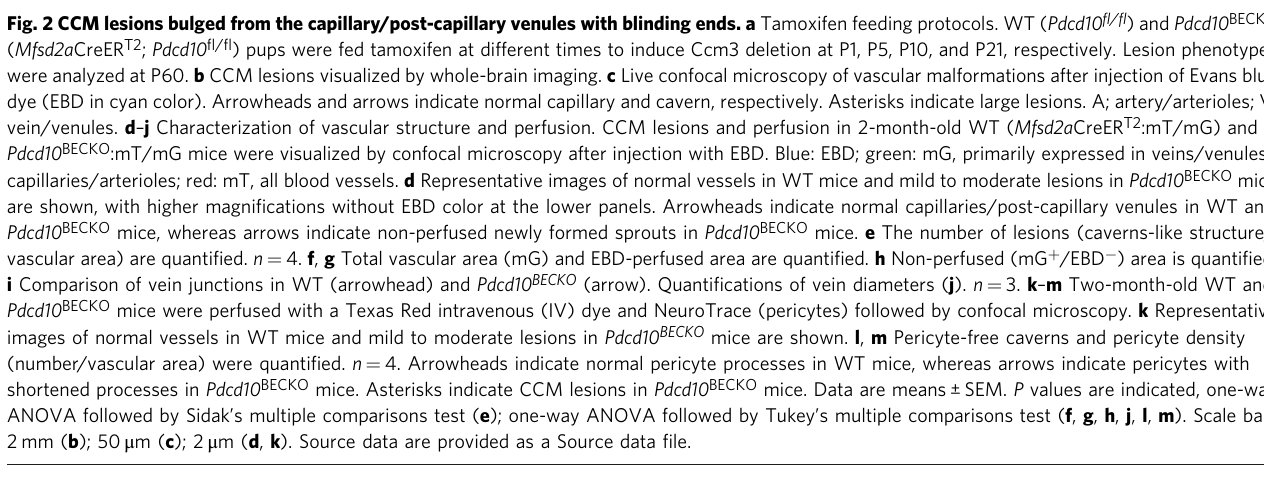
Fig. 2 CCM lesions bulged from the capillary/post-capillary venules with blinding ends. a Tamoxifen feeding protocols. WT ( Pdcd10 fl / fl ) and Pdcd10 BECKO ( Mfsd2a CreER T2 ; Pdcd10 fl / fl ) pups were fed tamoxifen at different times to induce Ccm3 deletion at P1, P5, P10, and P21, respectively. Lesion phenotypes were analyzed at P60. b CCM lesions visualized by whole-brain imaging. c Live confocal microscopy of vascular malformations after injection of Evans blue dye (EBD in cyan color). Arrowheads and arrows indicate normal capillary and cavern, respectively. Asterisks indicate large lesions. A; artery/arterioles; V: vein/venules. d – j Characterization of vascular structure and perfusion. CCM lesions and perfusion in 2-month-old WT ( Mfsd2a CreER T2 :mT/mG) and Pdcd10 BECKO :mT/mG mice were visualized by confocal microscopy after injection with EBD. Blue: EBD; green: mG, primarily expressed in veins/venules/ capillaries/arterioles; red: mT, all blood vessels. d Representative images of normal vessels in WT mice and mild to moderate lesions in Pdcd10 BECKO mice are shown, with higher magni fi cations without EBD color at the lower panels. Arrowheads indicate normal capillaries/post-capillary venules in WT and Pdcd10 BECKO mice, whereas arrows indicate non-perfused newly formed sprouts in Pdcd10 BECKO mice. e The number of lesions (caverns-like structure/ vascular area) are quanti fi ed. n = 4. f , g Total vascular area (mG) and EBD-perfused area are quanti fi ed. h Non-perfused (mG + /EBD − ) area is quanti fi ed. i Comparison of vein junctions in WT (arrowhead) and Pdcd10 BECKO (arrow). Quanti fi cations of vein diameters ( j ). n = 3. k – m Two-month-old WT and Pdcd10 BECKO mice were perfused with a Texas Red intravenous (IV) dye and NeuroTrace (pericytes) followed by confocal microscopy. k Representative images of normal vessels in WT mice and mild to moderate lesions in Pdcd10 BECKO mice are shown. l , m Pericyte-free caverns and pericyte density (number/vascular area) were quanti fi ed. n = 4. Arrowheads indicate normal pericyte processes in WT mice, whereas arrows indicate pericytes with shortened processes in Pdcd10 BECKO mice. Asterisks indicate CCM lesions in Pdcd10 BECKO mice. Data are means ± SEM. P values are indicated, one-way ANOVA followed by Sidak ’ s multiple comparisons test ( e ); one-way ANOVA followed by Tukey ’ s multiple comparisons test ( f , g , h , j , l , m ). Scale bar: 2 mm ( b ); 50 μ m ( c ); 2 μ m ( d , k ). Source data are provided as a Source data